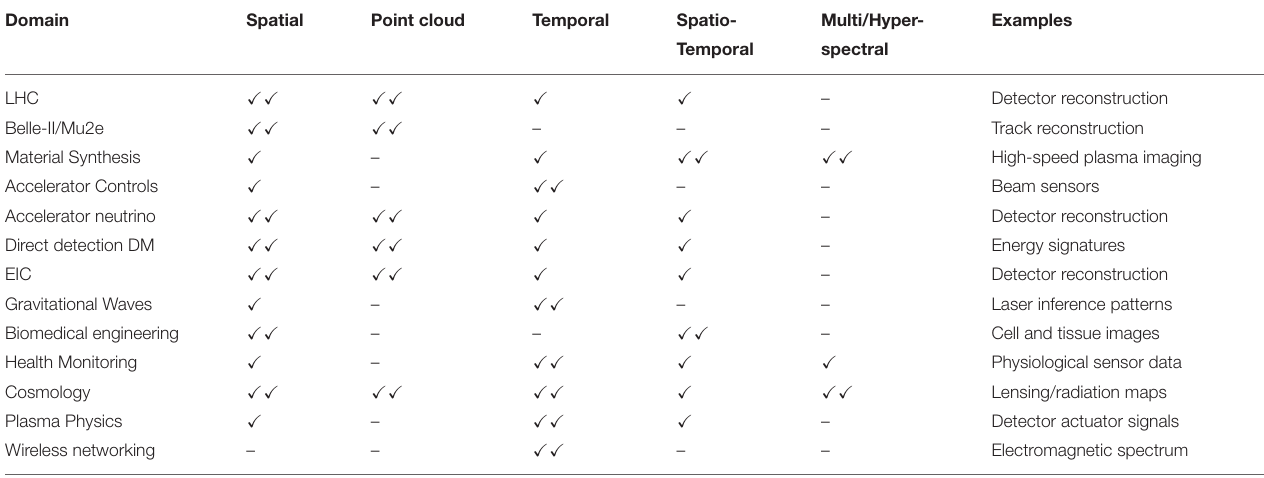
TABLE 1 | Types of data representations and their relevance for the scientific domains discussed in this paper; XX = Particularly important for domain, X = Relevant for